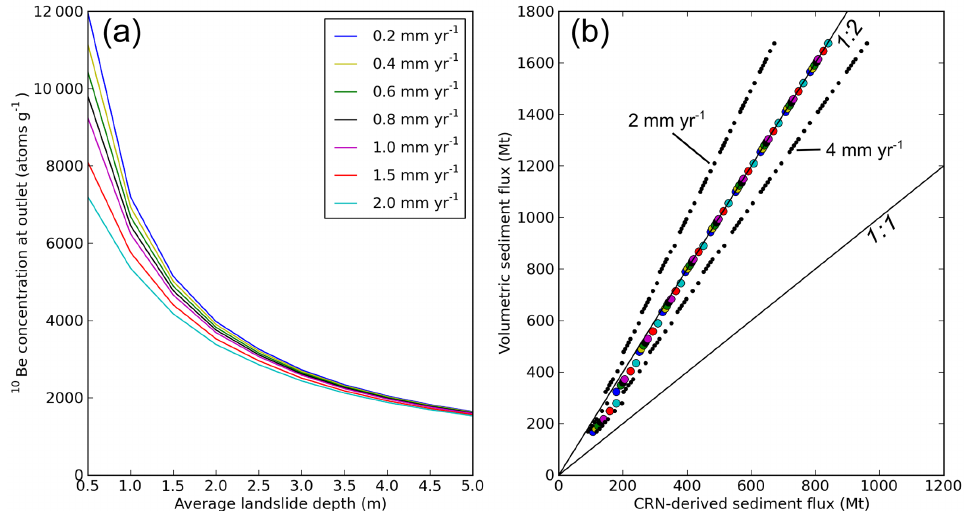
Figure 9. (a) Effect of increasing average landslide erosion rate to 3.0mmyr − 1 on outlet 10 Be concentrations in response to varying landslide depths and catchment background erosion rates. The overall range in outlet concentrations is notably lower than in Fig. 8a. Increasing the catchment-averaged erosion rate only has an impact on outlet concentrations where the input of landslide material is smaller, suggesting that the outlet concentration is dominated by landslide-derived material. (b) Comparison of volumetric and CRN-derived sediment fluxes for the same model conditions, where marker colour corresponds to background erosion rate shown in panel (a) . The difference in volumetric and CRN-derived fluxes is much less than scenarios shown in Fig. 8d. In general, the volumetric flux is approximately double the CRN-derived sediment flux. By increasing and decreasing the average landslide erosion rate to 4.0 and 2.0mmyr − 1 as shown by the smaller black markers, this relationship varies slightly.